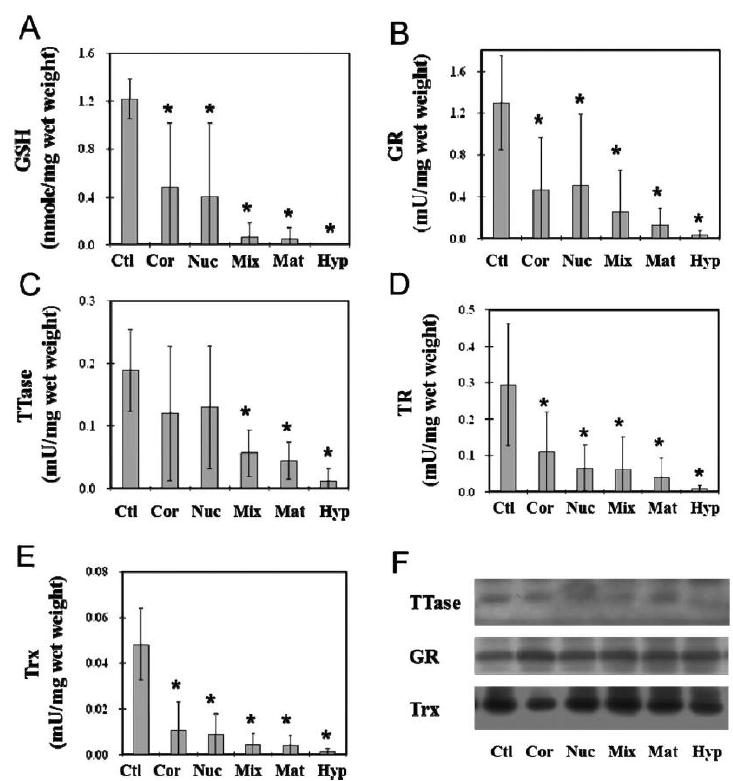
Figure 17. Comparison between thiol repair enzyme activities in normal nucleus and those in ECCE cataractous lenses . ECCE (extracapsular cataract extraction) procedure obtained nuclear portions of nine normal, clear human lenses (Ctl) and whole tissues of human ECCE cataractous lenses of different types of cataracts were used. The cataractous lens samples included 28 cortical (Cor), 26 nuclear (Nuc), 17 mixed cortical and nuclear (Mix), 17 mature cataracts (Mat), and 9 hypermature cataracts (Hyp). Each lens preparation was assayed for GR, TR, TTase, and TRx activities. An aliquot of deproteinized lens homogenate was used for GSH analysis. Data are expressed as means ± SD. * p < 0.05 by comparison with the control. Equal amounts of proteins from the above sample preparation were used for Western blot analysis for the protein content of TTase, GR, and Trx, using specific antibodies for TTase, GR, and Trx. ( A ) GSH level; ( B ) GR activity; ( C ) TTase activity; ( D ) TR activity; ( E ) Trx activity; ( F ) Western blot analysis of TTase, GR, and TRx in human cataractous